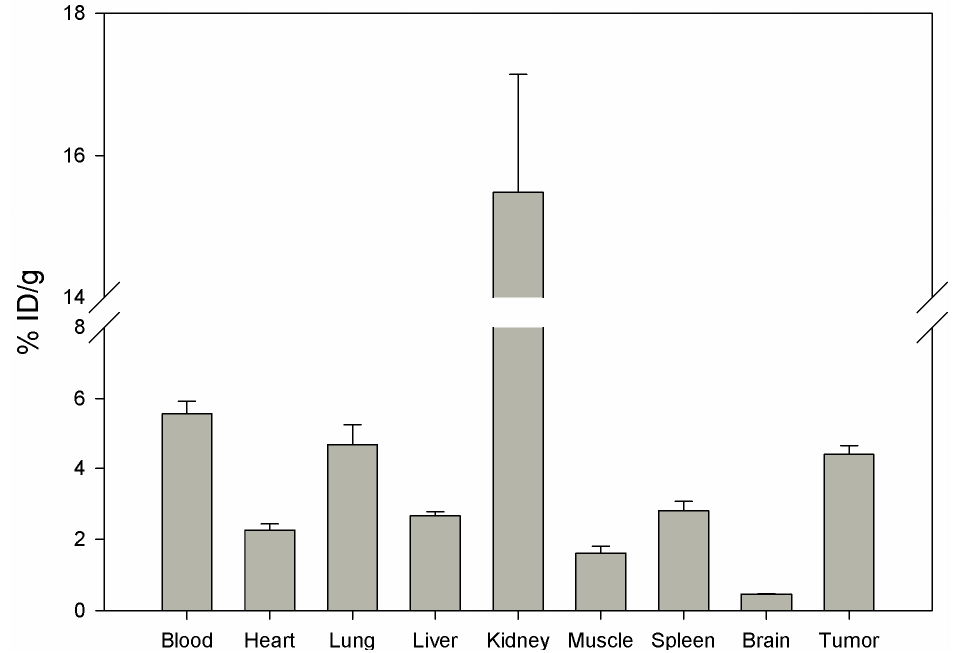
Activity concentration (% ID/g) in tumor and control organs is measured after 15 min (n = 3 animals) circulation of the radioligand. Mean values and standard